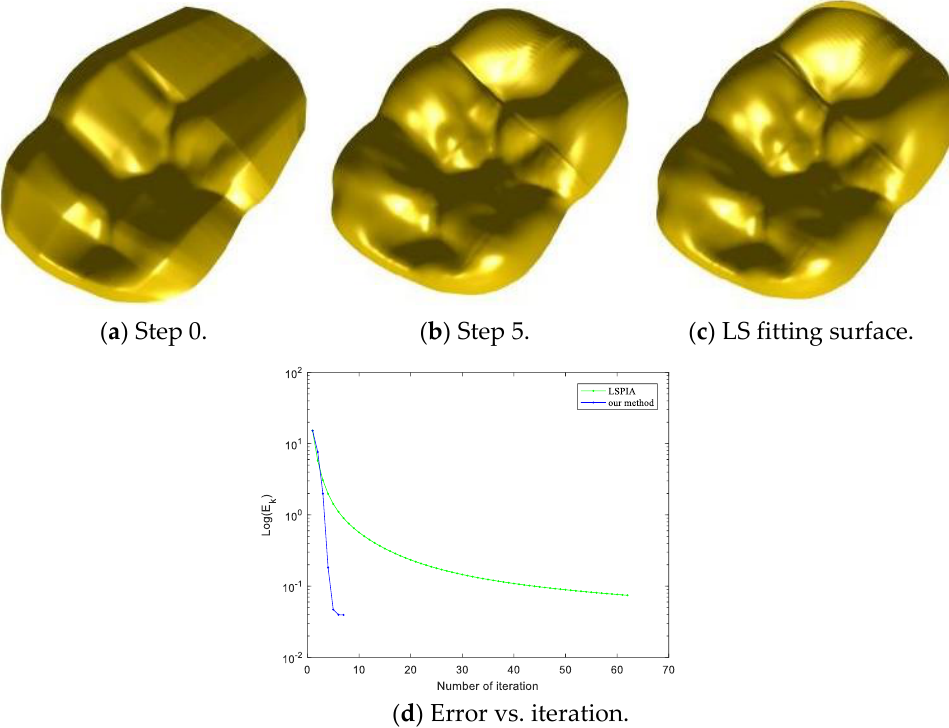
Figure 5. A data point grid with 81 × 61 points was fitted by a bi − cubic tensor product B − spline surface with 40 × 30 control points.